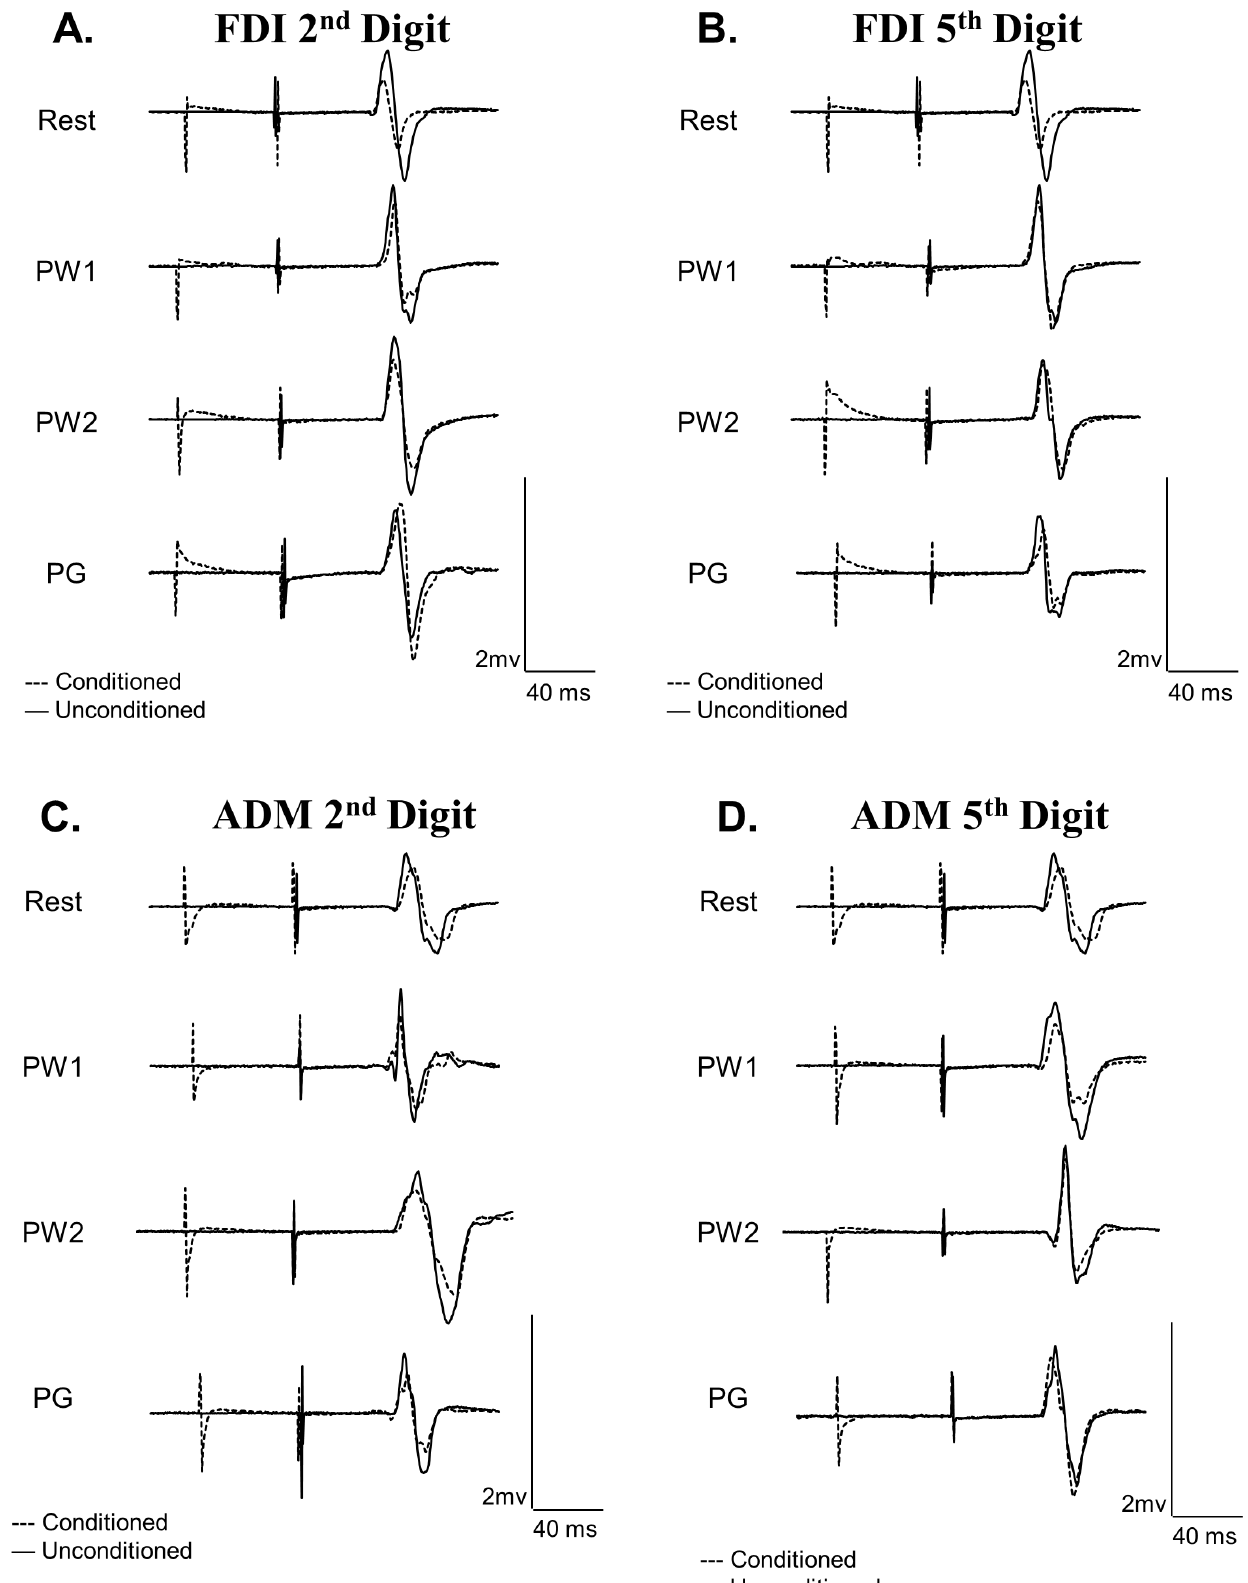
Figure 3. Raw traces of conditioned and unconditioned MEPs for FDI and ADM. Each trace is an individual trial that is representative of the group-averaged data. A : Raw EMG traces of SAI in FDI during preparation for 2 nd digit movement. B : Raw EMG traces of SAI in FDI during preparation for 5 th digit movement. C : Raw EMG traces of SAI in ADM during preparation for 2 nd digit movement. D : Raw EMG traces of SAI in FDI during preparation for 5 th digit movement. doi:10.1371/journal.pone.0104807.g003 PLOS ONE | www.plosone.org